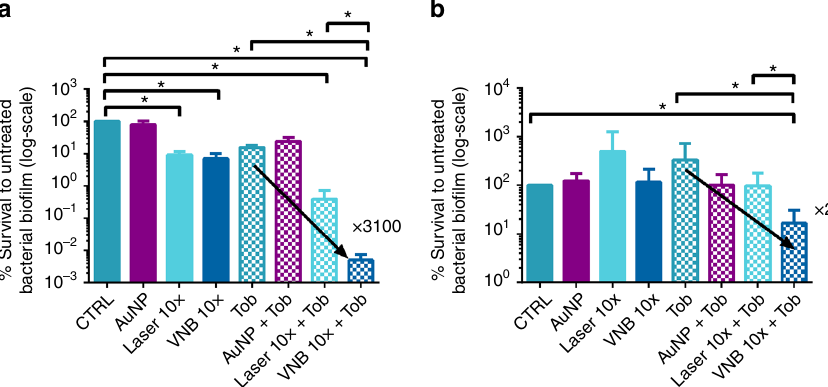
Fig. 6 Bio fi lm survival after 10× VNB formation followed by tobramycin treatment. Log of the % survival CFU/bio fi lm compared to the untreated control (average ± SEM) in a P. aeruginosa and b S. aureus bio fi lms. Control: 0.9% NaCl solution, AuNP: only addition of 70 nm spherical gold nanoparticles, Laser: only laser treatment (each location of the bio fi lm received 10 laser pulses), VNB: addition of AuNP with subsequent laser treatment to form vapour nanobubbles, Tob: tobramycin treatment for 24 h at 37 °C, AuNP + Tob: addition of AuNP with subsequent tobramycin treatment, Laser + Tob: laser and subsequent tobramycin treatment, VNB + Tob: addition of AuNP with subsequent laser and tobramycin treatment. CTRL contained 2 × 10 7 ± 7 × 10 6 CFU/ bio fi lm or 1 × 10 6 ± 3 × 10 5 CFU/bio fi lm for P. aeruginosa or S. aureus bio fi lms, respectively. Each antibio fi lm effect was tested in 4 biological repeats and each biological repeat consisted of 3 technical repeats ( n = 4 × 3) ( p < 0.05; The Shapiro – Wilk test was used to test the normality of the data sets. The one-way analysis of variance test and independent samples T -test were used for normal distributed data. The Kruskal – Wallis test and Mann – Whitney U test were used for non-normally distributed